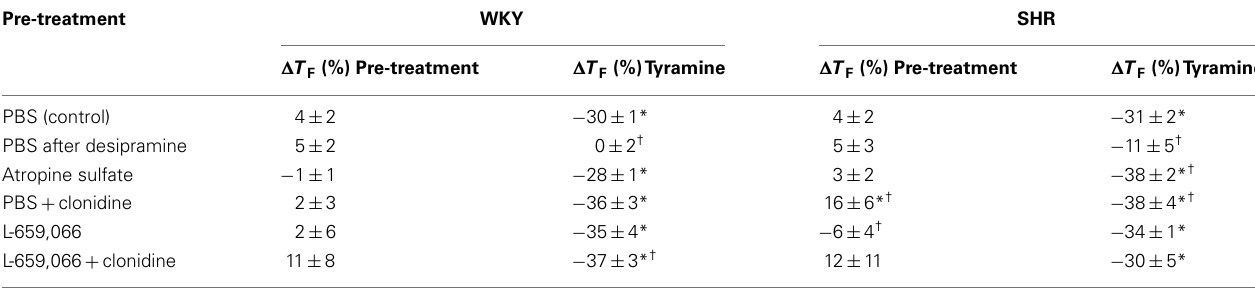
Table 2 | Changes in T F as an indication of changes in inotropy in response to pre-treatment and tyramine.